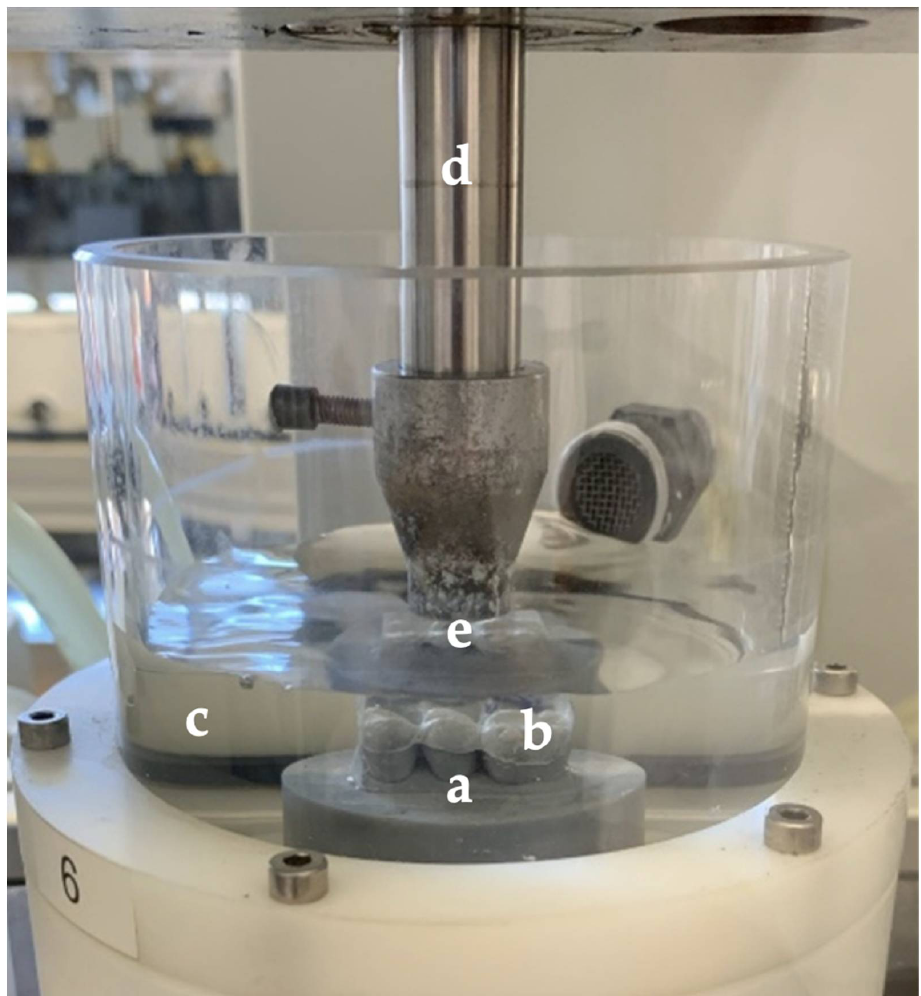
Figure 5. Picture of the test specimen holder ( a ) with the adhesively fixed partial Michigan splint ( b ) in the watered specimen chamber ( c ) of the computer-controlled chewing simulator showing the vertical bar for vertical movements ( d ) and the artificial antagonist ( e ).